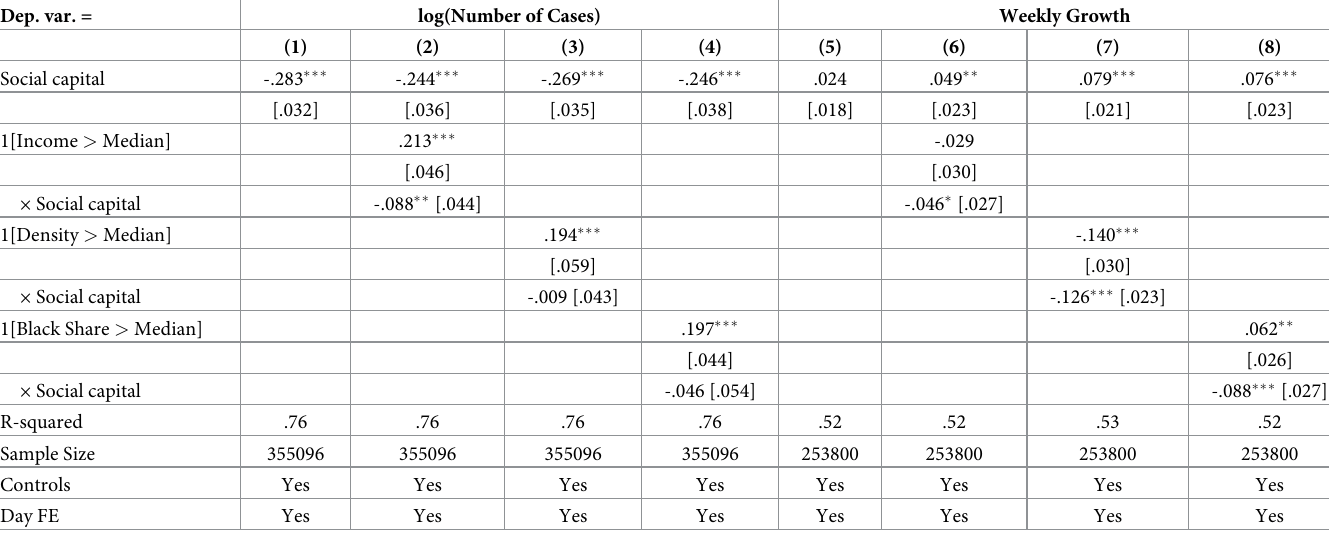
Table 2. Examining evidence of heterogeneous treatment effects. Dep. var.